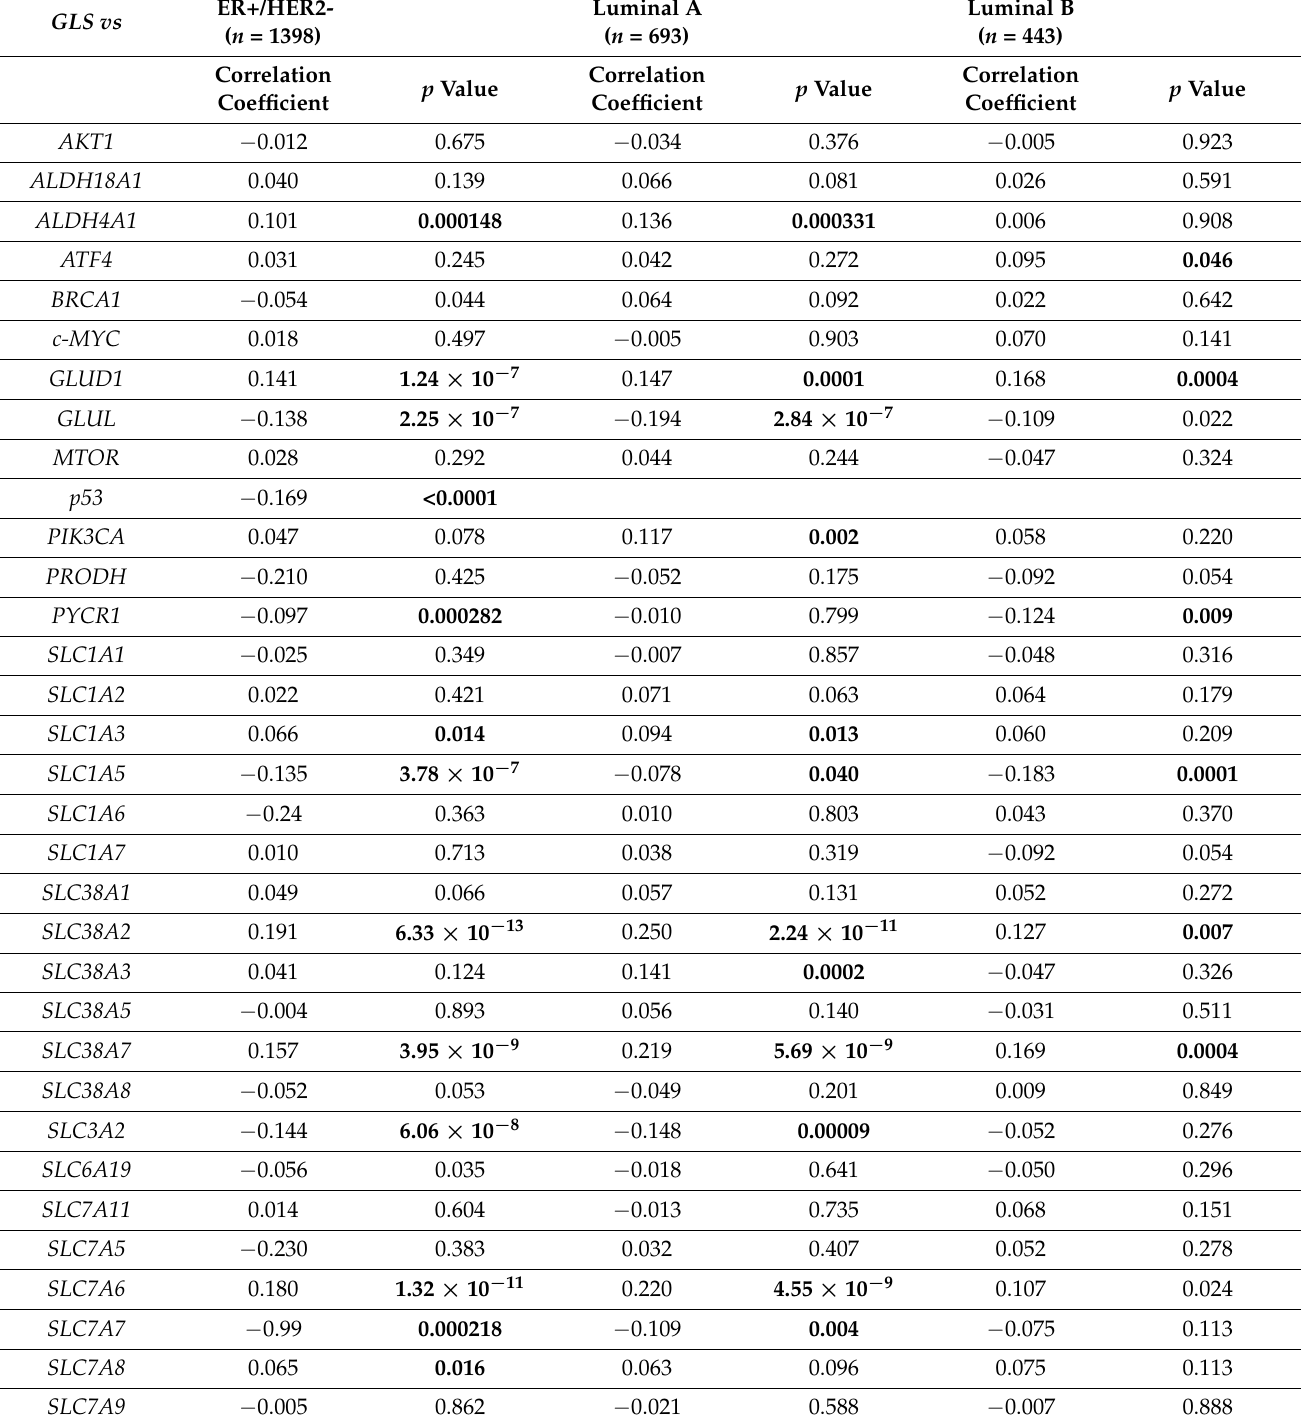
Table 1. Correlation of GLS mRNA expression with glutamine-metabolism-related mRNA in invasive luminal breast cancer. GLS